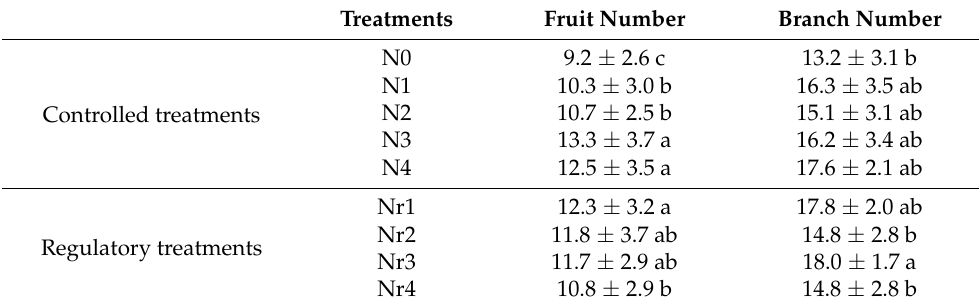
Table 4. Branches and fruit parameters of tested pear